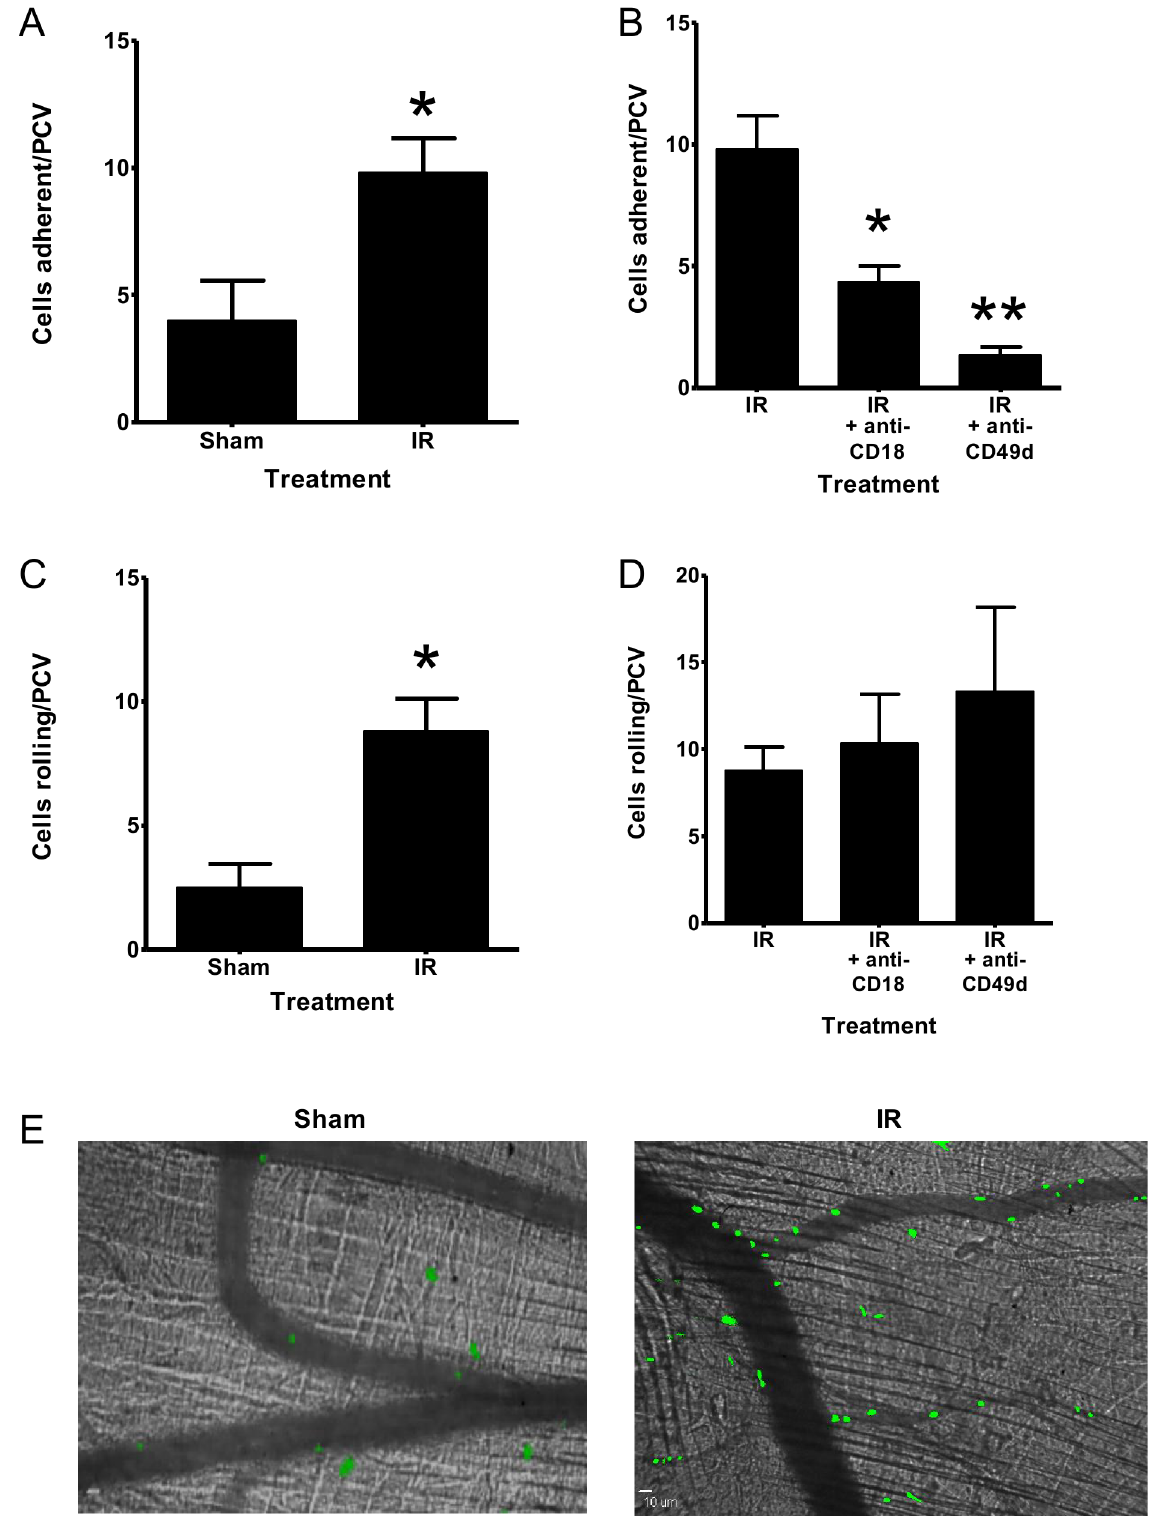
Figure 5. HPC-7 adhesion invivo is increased in IR injured muscle and is dependent on CD49d. (A) HPC-7 adhesion to cremaster PCVs was enhanced following IR injury. (B) Pre-treating HPC-7 with an anti-CD18 or anti-CD49d blocking antibody reduced HPC-7 adhesion. (C) IR injury enhanced HPC-7 rolling in PCVs. (D) Blocking with anti-CD18 or anti-CD49d antibodies did not enhance rolling above that seen with IR injury alone. (E) Representative images (x10 magnification) of HPC-7 adhesion in sham and IR injury are shown. Results are presented as mean adhesion 6 SEM (n $ 3/group); A/C: * p , 0.05, IR vs Sham; B: * p , 0.05, ** p , 0.01, IR vs antibody blocked cells.